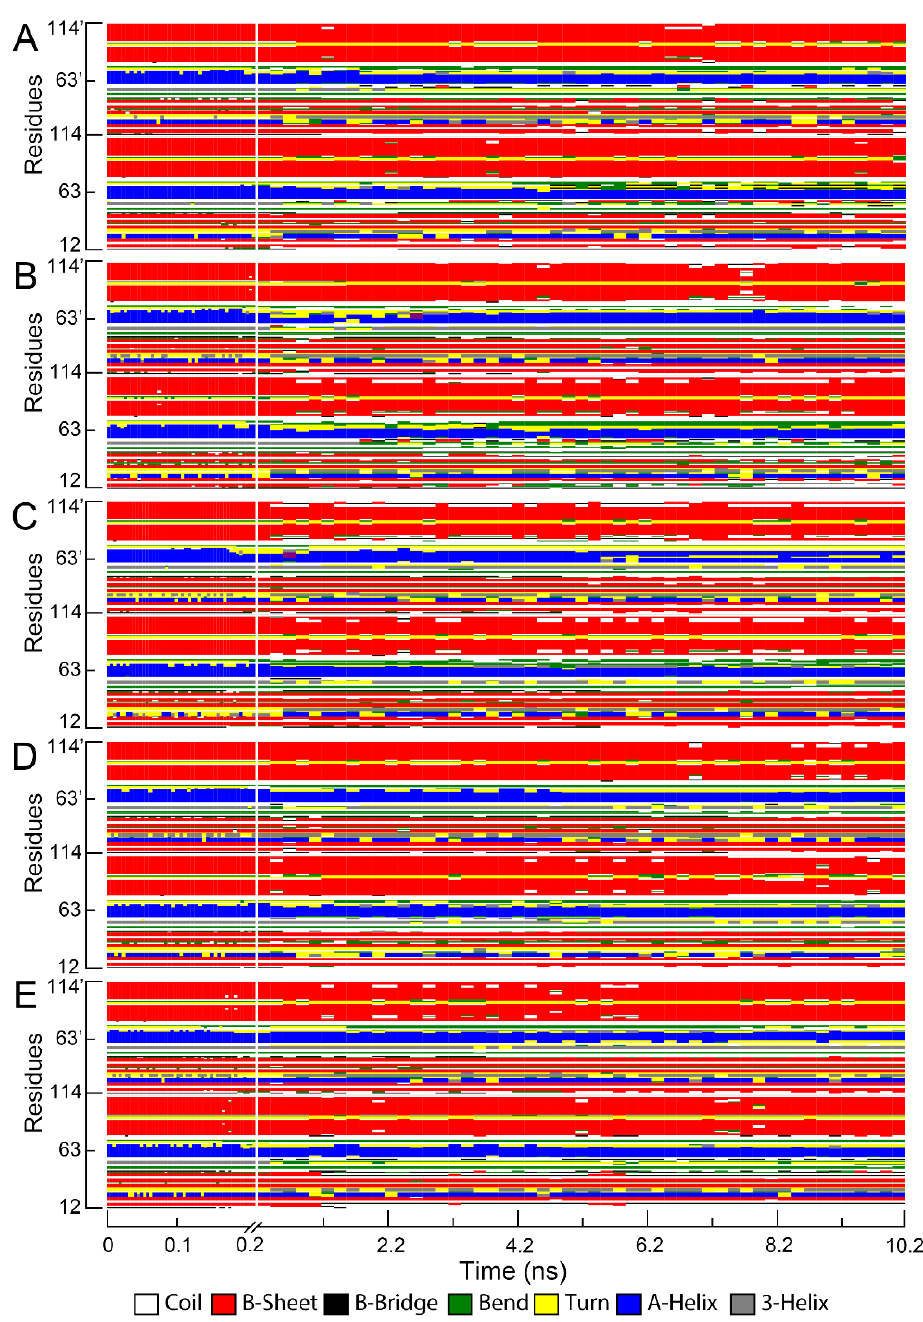
Figure 6. Secondary structures of BMP-2 upon HAP and Zn-HAPs during the binding and adsorption processes. (0 to ~0.2 ns: binding process; ~0.2 to ~10.2 ns: adsorption process. ( A ), HAP; ( B ), Zn1-HAP; ( C ), Zn2.5-HAP; ( D ), Zn5-HAP; ( E ), Zn10-HAP).